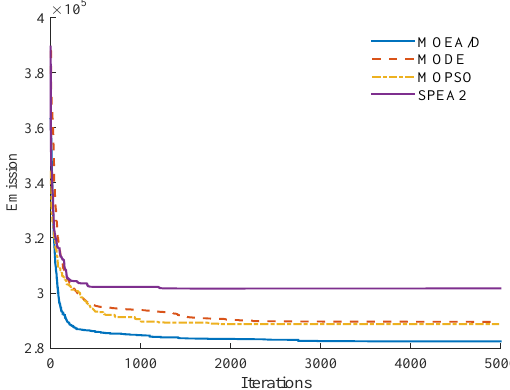
Figure 6. Convergence property of cost objective function.